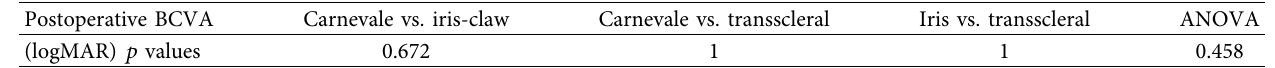
Table 4: Intergroup postop visual acuity results of ANOVA and Bonferroni test.